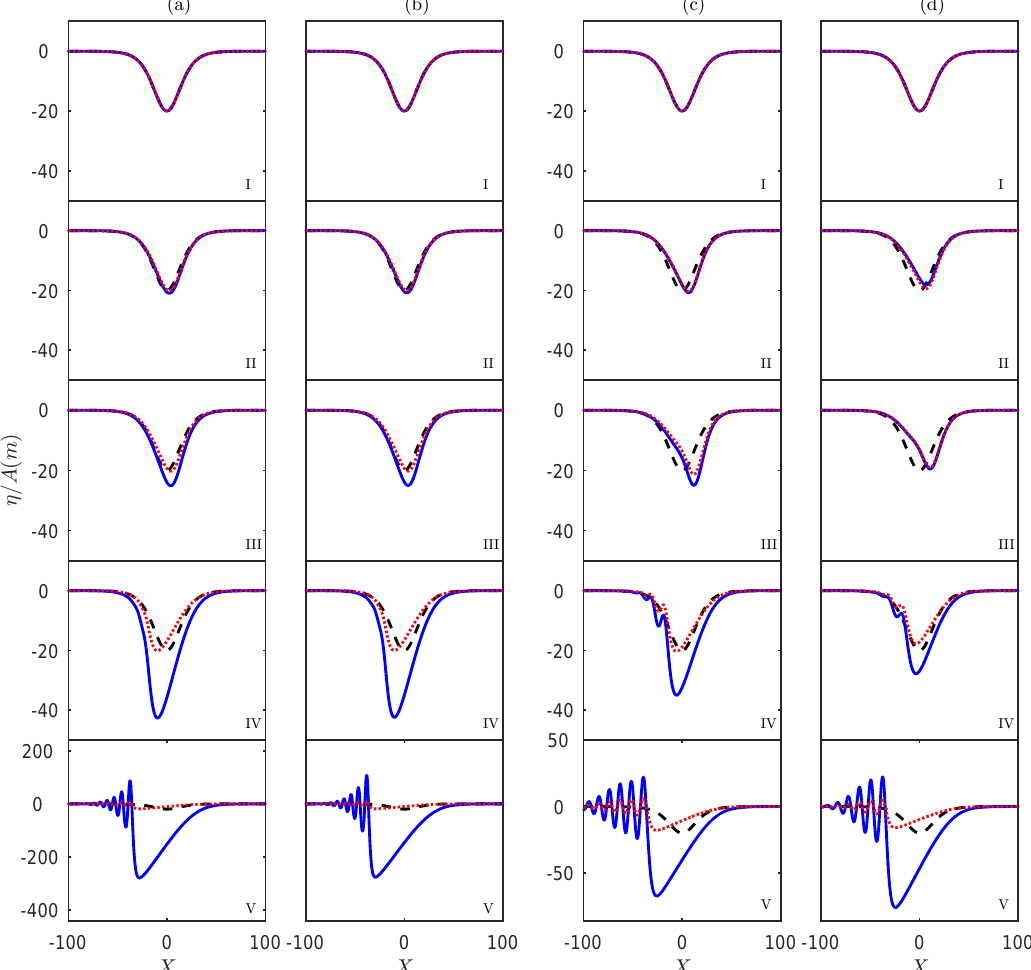
Figure 10. A numerical simulation of the vKdV Equation (5) for the North West Shelf case for summer ( a , b ) and winter ( c , d ) conditions, with u 0 = 0 ( a , c ) or u 0 (cid:54) = 0 ( b , d ), respectively. The initial condition is the solitary wave (black, dash), the numerical solution is ˜ A (red, dot) and the physical solution is η (blue, solid). From top to bottom, the distances from the initial point are (I) 0 km, (II) 110 km, (III) 220 km, (IV) 330 km, (V) 440 km,